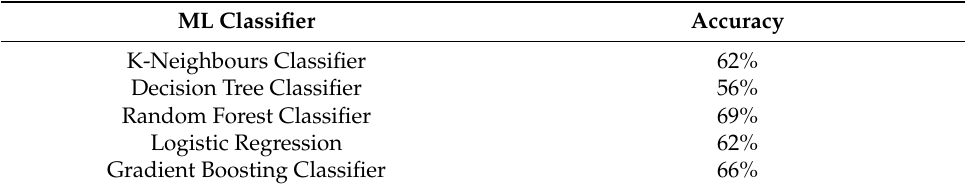
Table 4. Accuracy results achieved by different ML techniques.